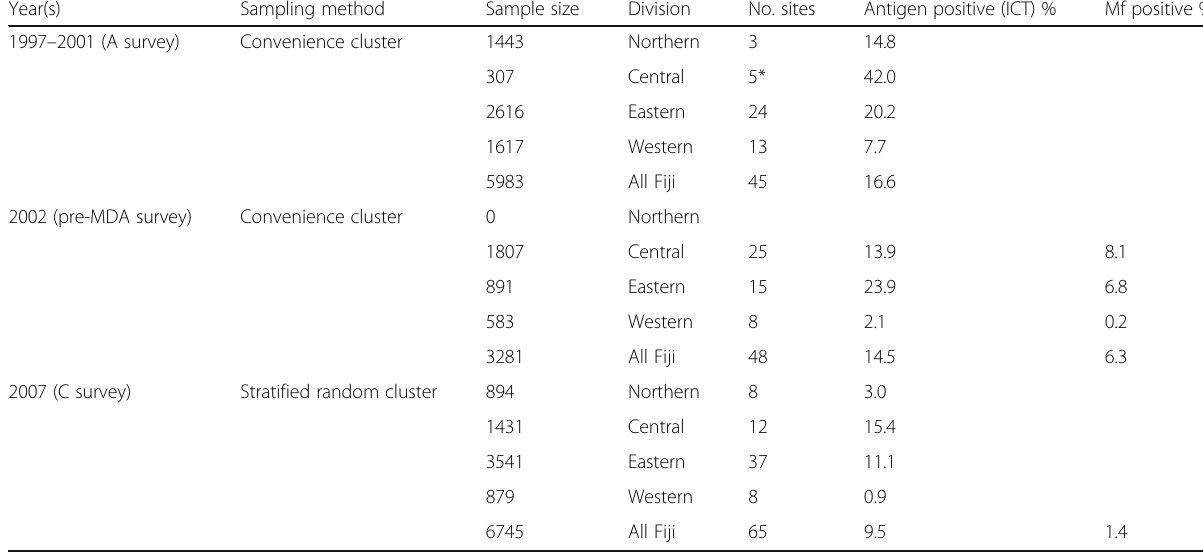
Table 4 LF prevalence in Fiji by division (positive ICT %)